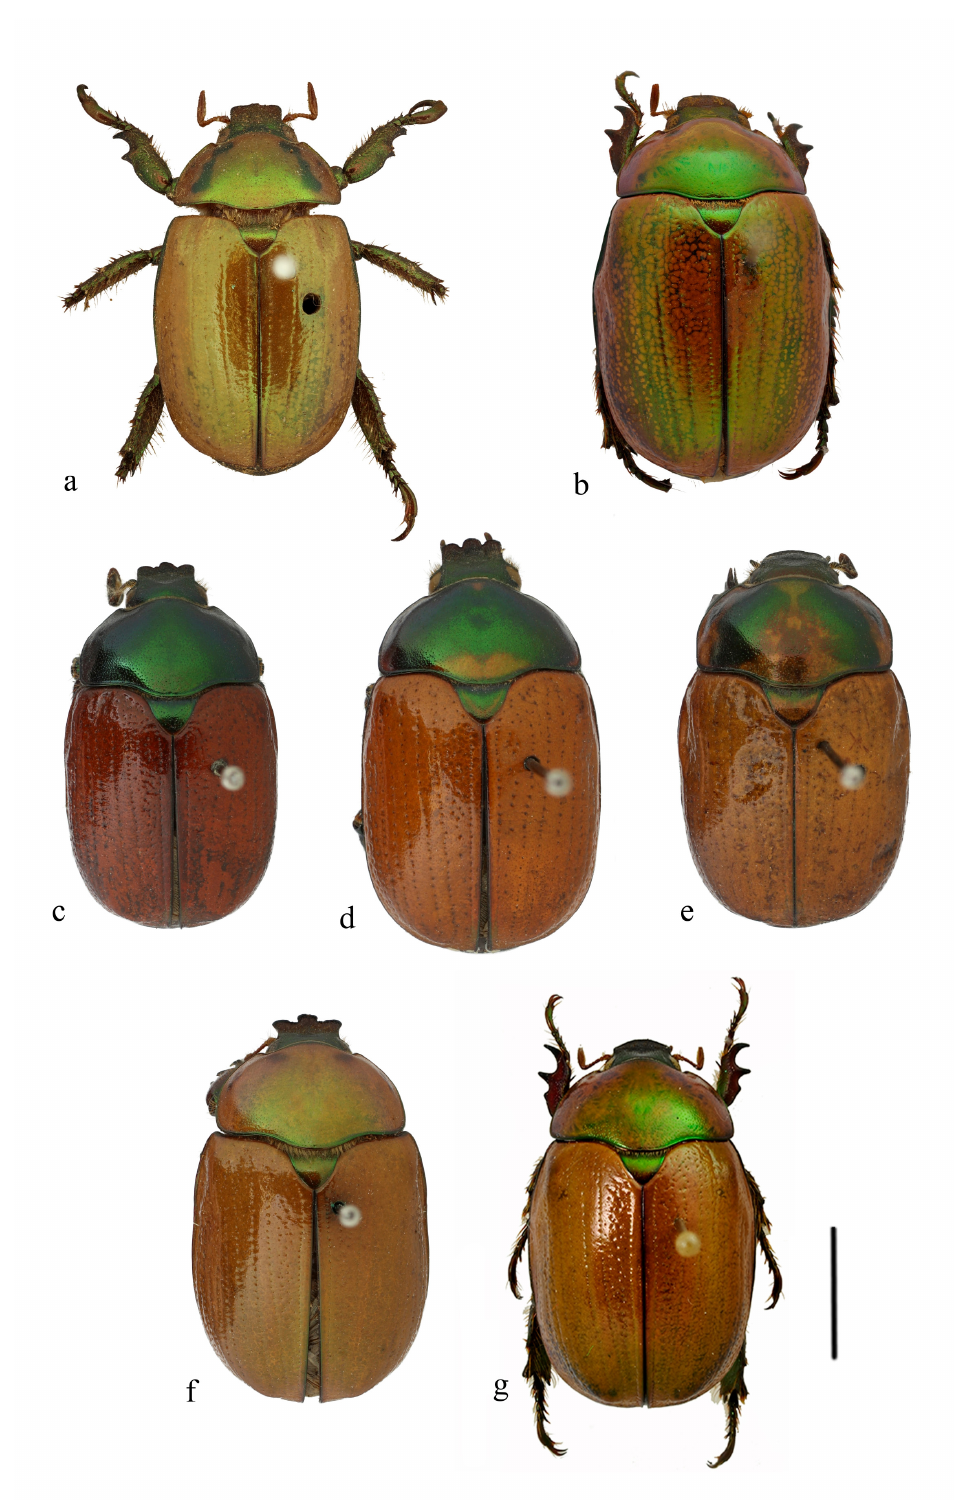
Fig. 1. a–b . Oplognathus kirbii MacLeay, 1819. a . Neotype, ♂ (NHMUK). b . Female specimen (MZUSP). c . O. helmenreichi Ohaus, 1905, holotype, ♂ (ZMHB). d–e . O. helmenreichi var. maculicollis Ohaus, 1914. d . Syntype, ♂ (ZMHB). e . Syntype, ♀ (ZMHB). f–g . O. bahianus Ohaus, 1912. f . Syntype, ♂ (ZMHB). g . Female specimen (EPGC) . Scale bar = 5